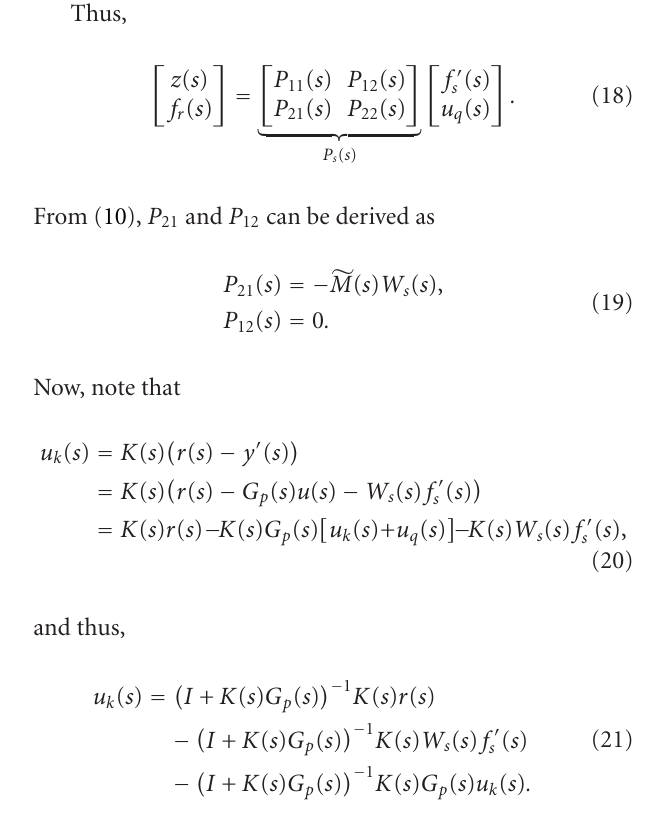
stable with respect to norm-bounded matrix perturbation [16]. The equivalent linear fractional transformation (LFT) block diagram for the H ∞ problem stated above is shown in Figure